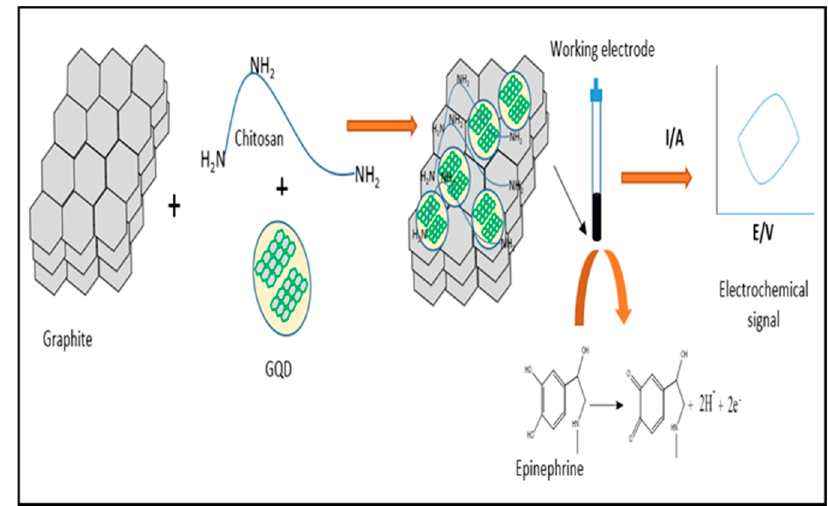
Figure 15. Electrochemical detection of EP using GQDs/Chitosan composite (Reproduced from [86]).